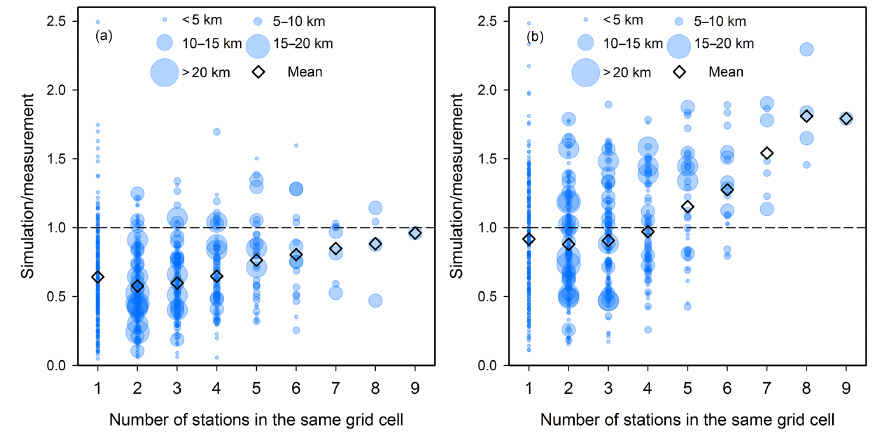
Figure 8. Correlation among the number of stations in the same model grid cell, ratio of the simulated annual mean surface NO 2 concentra- tions in 2015 driven by (a) the DECSO inventory, 2015, or (b) the MIX Asian inventory, 2010, to the corrected in situ measurements, and the average distance among stations located in the same grid cell. The magnitude of the size of the circle denotes the average distance between stations located in the same grid cell. The diamond denotes the average ratio of simulations to measurements for grid cells with different numbers of